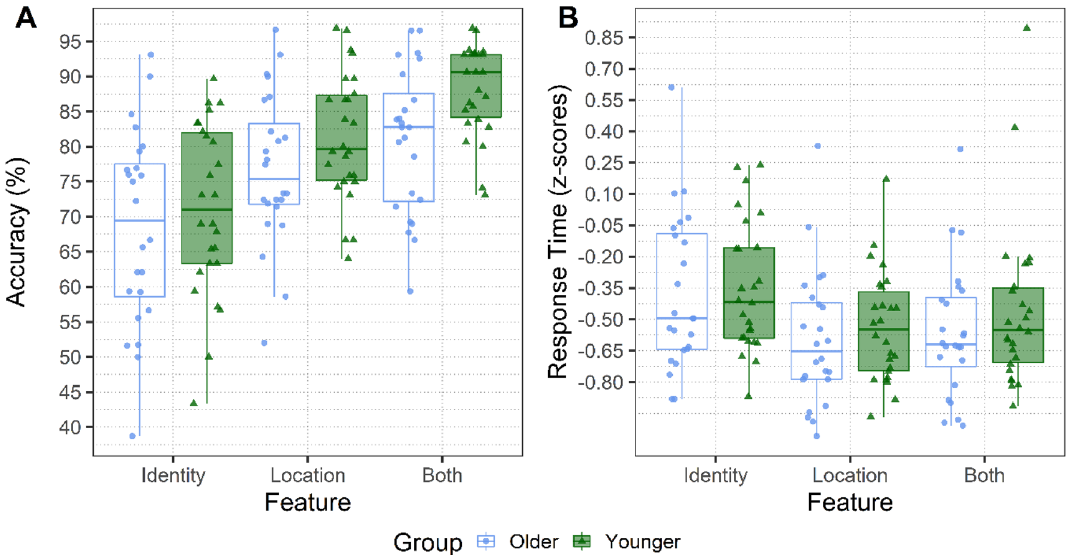
Figure 5. Manual responses: ( A ) The percentage accuracy of the change detection task. ( B ) The response time for correct trials is z-scored. Both measures are plotted on the y-axis as a function of the different Types of Change (Identity, Location, and Both). The two Groups of participants are compared within each panel. The Younger group is depicted in green, whereas the Older group is depicted in blue. The hinges of the boxplots represent the 25th and 75th percentiles of the measure (lower and upper quartiles). The horizontal line represents instead the median of the distribution. Each dot indicates the by-participant average for that factor.